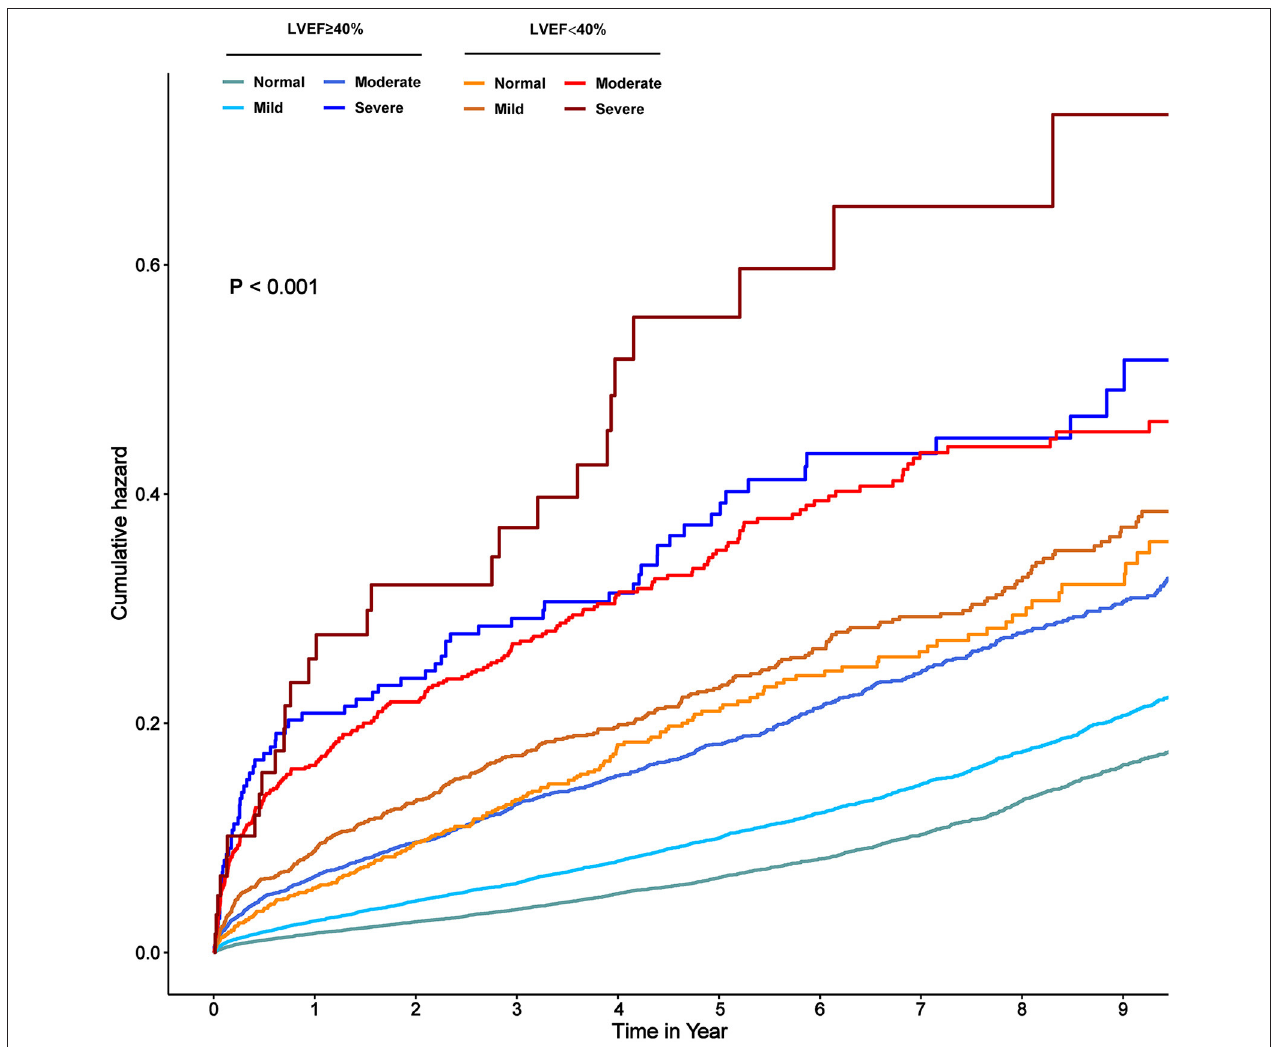
FIGURE 2 | Kaplan–Meier curve in terms of all-cause mortality in normal, mildly, and moderate to severe malnourished patients with and without LVEF < 40%. Normal, Mild, Moderate, and Severe correspond to the state of malnutrition, respectively, based on the CONUT score. Normal: CONUT 0–1; Mild: CONUT 2–4; Moderate: CONUT 5–8; Severe: CONUT